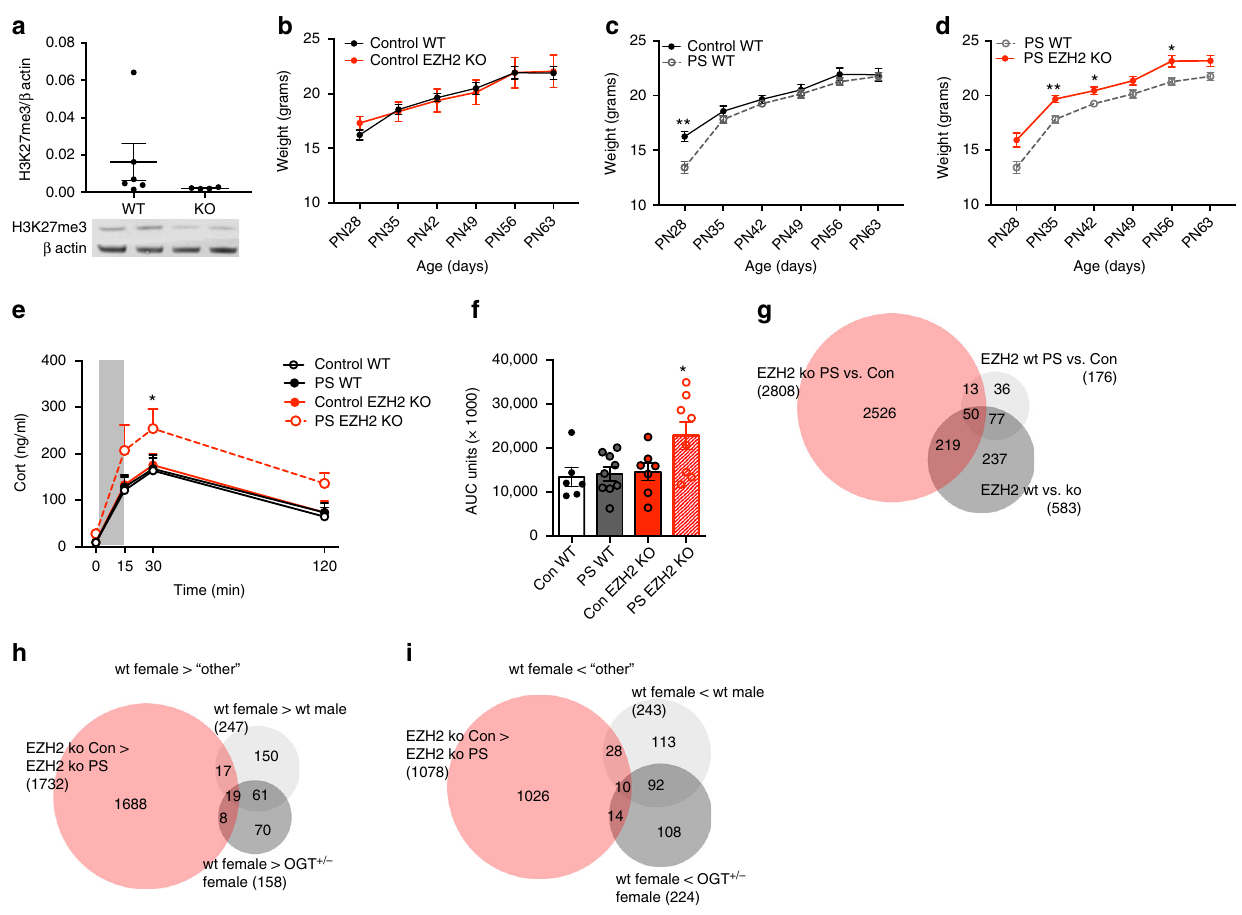
Fig. 4 Placental Ezh2 genetic deletion promotes female vulnerability to prenatal stress. a Trophoblast-speci fi c Ezh2 KO patterns H3K27me3 in female E12.5 placentas ( t -test, t (8) = 1.142, p = 0.1433; n = 6 WT, n = 4 KO from 6 litters with n = 1/group/litter). b Trophoblast-speci fi c Ezh2 KO alone has no impact on post-weaning body weight in females unexposed to prenatal stress. c Although prenatal stress (PS) exposed WT females weigh less at weaning (PN28, t (13) = 3.989, p = 0.009), there were no long-term effects of stress on WT female body weights. d However, when females with trophoblast-speci fi c Ezh2 KO were exposed to PS they showed increased body weights into adulthood (PN28, t (9) = 2.846, p = 0.056; PN35, t (16) = 3.987, p = 0.006; PN42, t (16) = 2.857, p = 0.044; PN56, t (16) = 3.258, p = 0.024; PN63, t (16) = 2.346, p = 0.063; n = 8 Con WT, n = 10 PS WT, n = 4 Con Ezh2 KO, n = 8 PS Ezh2 KO from 7 PS and 8 Con litters with a maximum of 2/genotype/litter). e Plasma corticosterone levels were signi fi cantly higher in response to a 15-min restraint stress in females with trophoblast- Ezh2 KO exposed to PS relative to control WT and PS WT groups (Two-way repeated measures ANOVA, F int (9,78) = 0.4101, p = 0.9261, F time (3,78) = 38.66, p < 0.0001, F group (3,26) = 3.76, p = 0.0229, F subjects(matching) (26,78) = 1.913, p = 0.0235). f Corticosterone area under the curve (AUC; ANOVA, F (3,26) = 3.77, p = 0.023; n = 6 Con WT, n = 9 PS WT, n = 7 Con Ezh2 KO, n = 8 PS Ezh2 KO from 7 PS and 8 Con litters with a maximum of 2/genotype/litter). g Venn diagram displaying the number of differentially expressed genes in the hypothalamus of trophoblast WT female fetuses exposed to PS ( n = 180 genes), non-stress exposed trophoblast Ezh2 WT vs. KO females ( n = 603 genes), and females with trophoblast-speci fi c Ezh2 KO exposed to PS vs. control treatment ( n = 2884 genes) at E18.5 ( n = 6 Con WT, n = 5 PS WT, n = 3 Con Ezh2 KO, n = 4 PS Ezh2 KO from 14 PS and 14 Con litters with a maximum of 1/genotype/litter). h Venn diagram comparing enriched gene expression in the WT female hypothalamus compared to males, trophoblast X ogt − /X wt females, and trophoblast Ezh2 KO females. i Venn diagram comparing downregulated hypothalamic genes in WT females relative to males, trophoblast X ogt − /X wt females, and trophoblast Ezh2 KO females. * p < 0.05, ** p < 0.01.